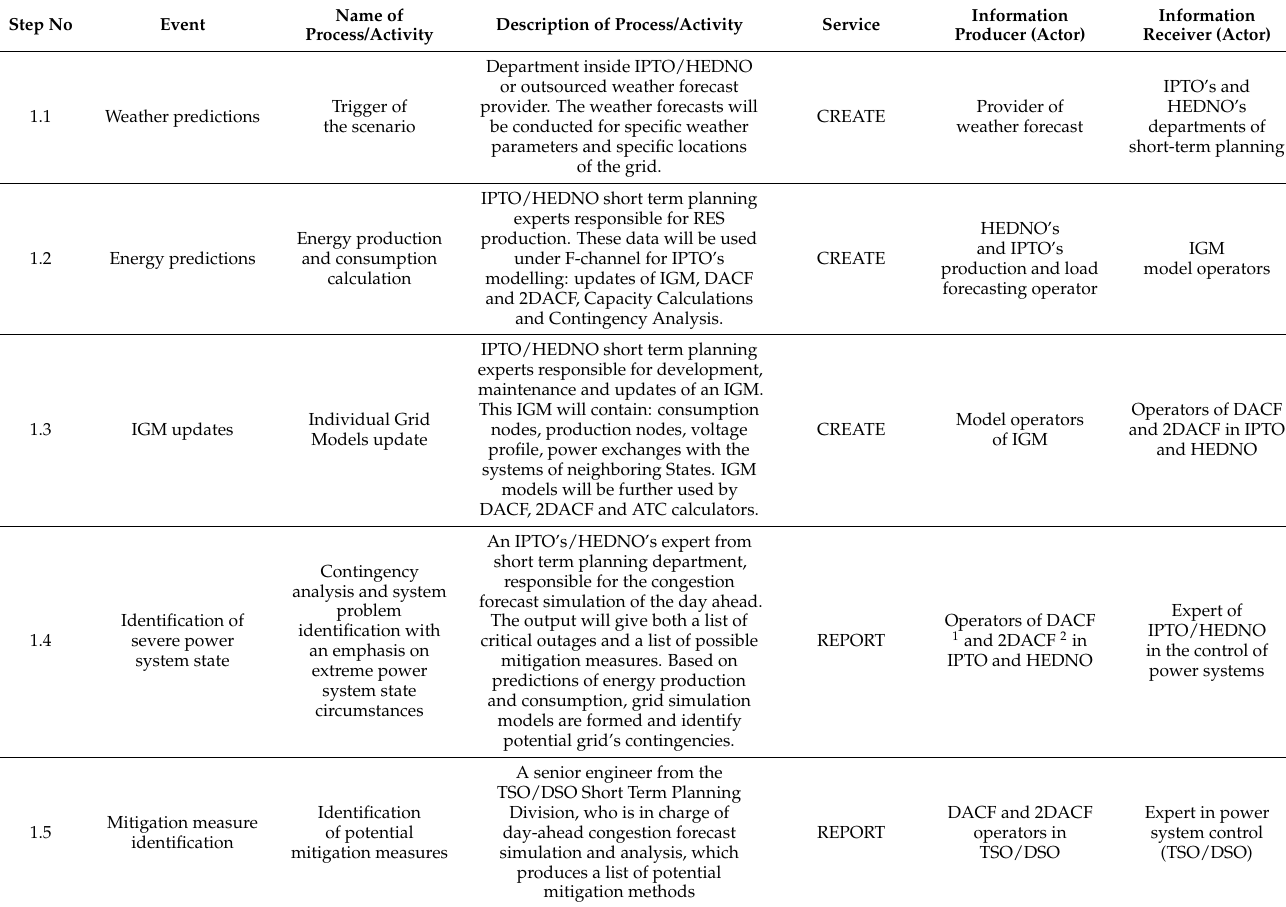
Table 5. Step-by-step analysis for the scenario.